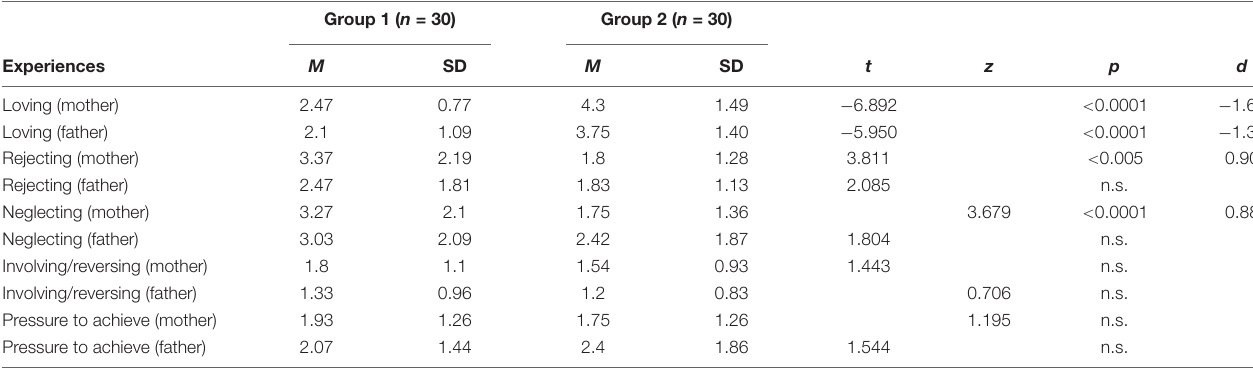
TABLE 2 | Descriptive statistics for AAI Scales for Inferred Experiences with Parents.